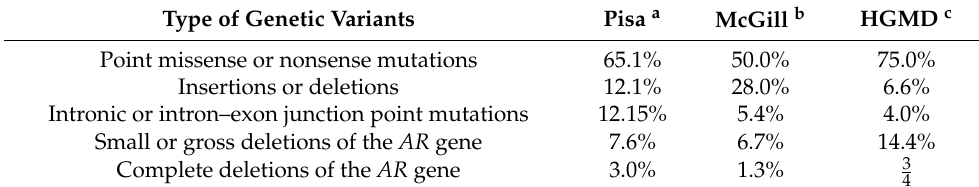
Table 1. AR genetic variants in complete androgen insensitivity syndrome (CAIS): personal experi- ence in comparison with international databases